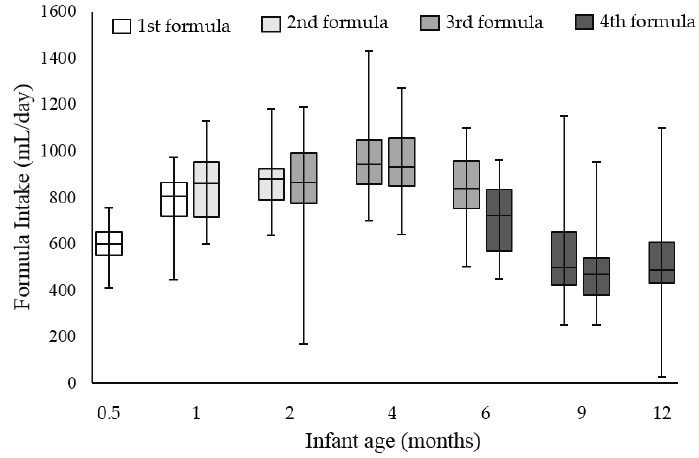
Figure 4. Boxplots of daily intake of study formulas. Data are presented as the average intake per day over three days recorded in the parent-held formula intake booklets. n = 29, 28, 27, 29, 28, 28, 27, 28, 25, 25, 28, 26, and 25, respectively.